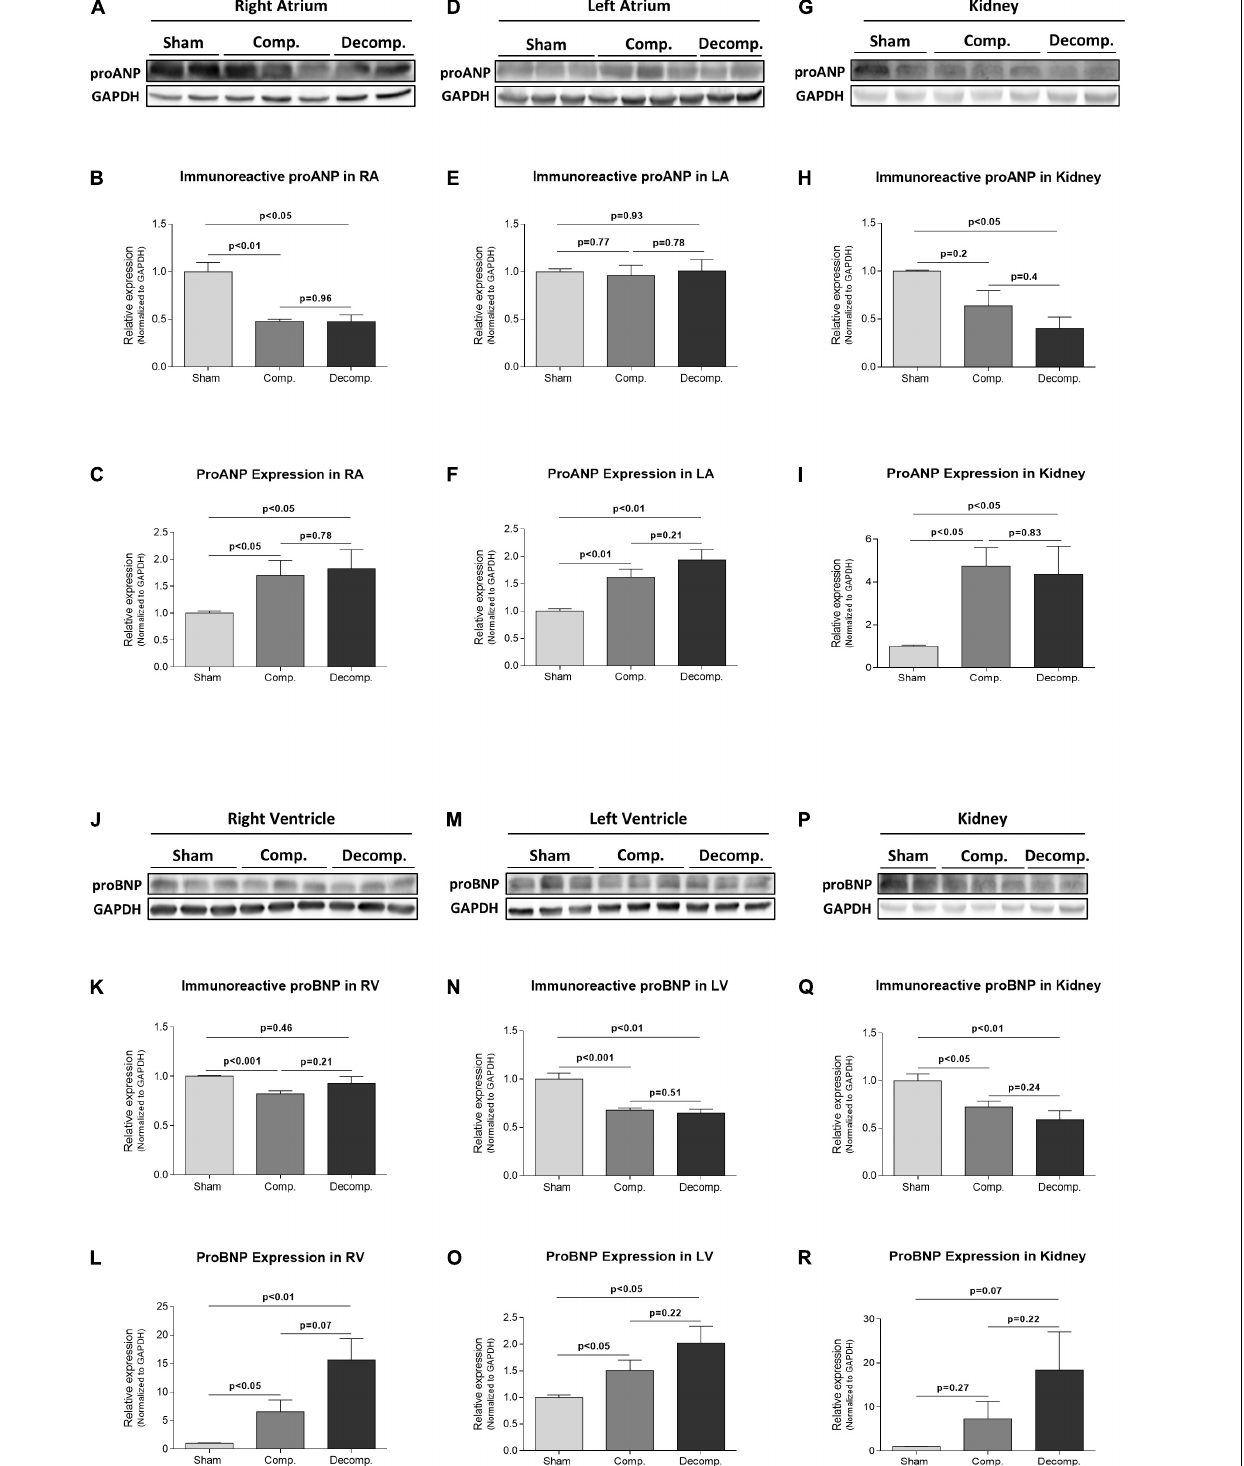
Frontiers in Physiology |